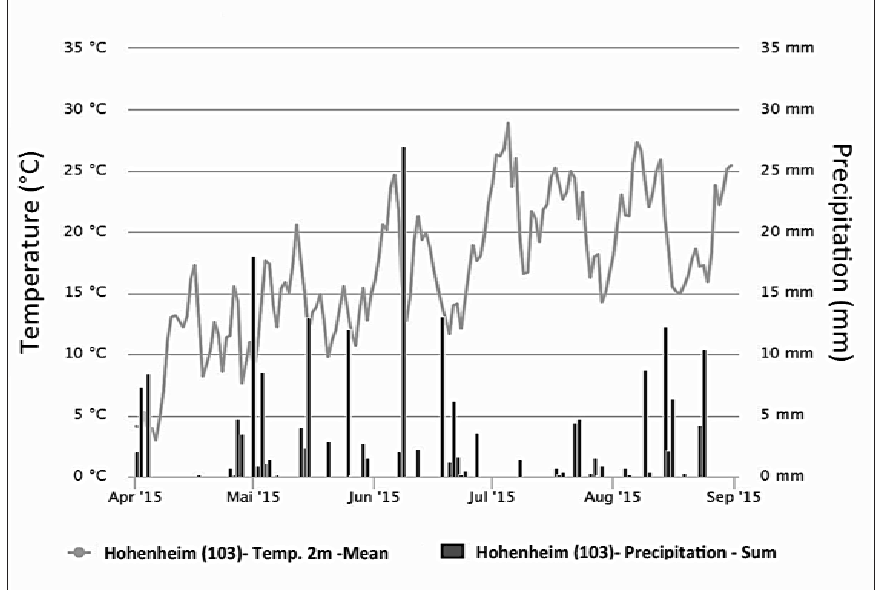
Fig. S1: Daily mean precipitation and temperature over the main onion growing season in Kleinhohenheim, Stuttgart, Germany. Source: Agrarmeterologie